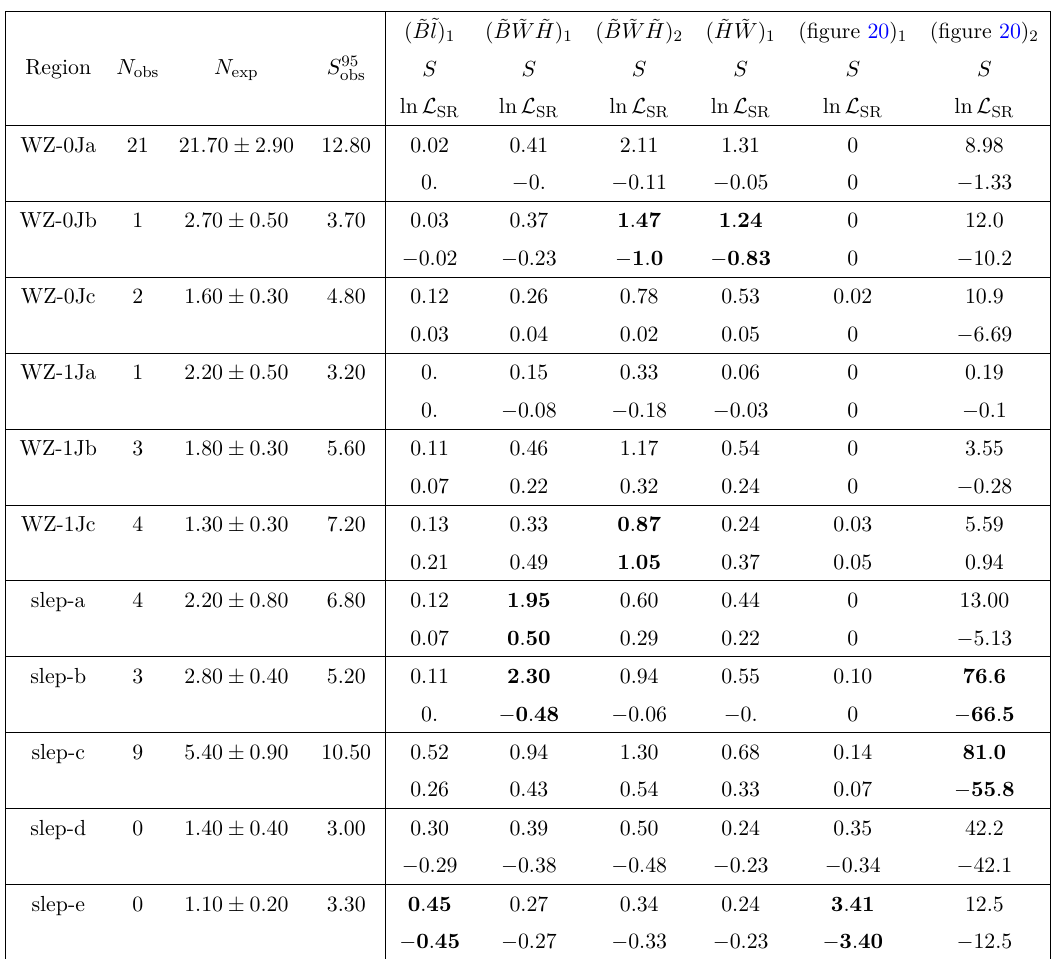
Table 5. Detailed results for the sample parameter points defined in table 4 versus the